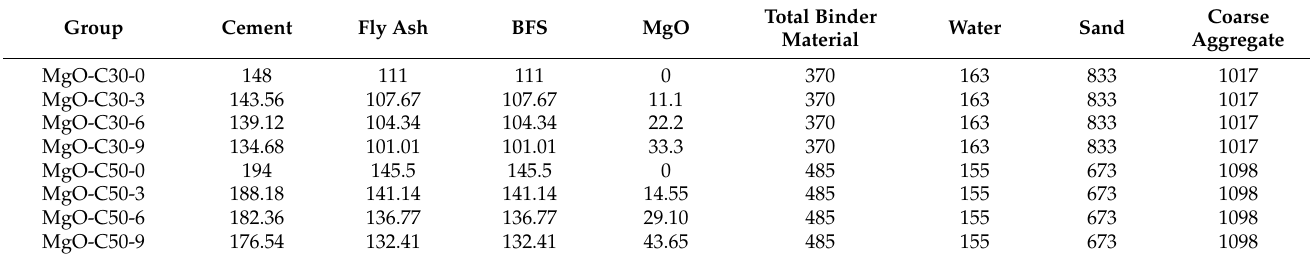
Table 3. The mix ratio of C30 and C50 concrete (kg/m 3